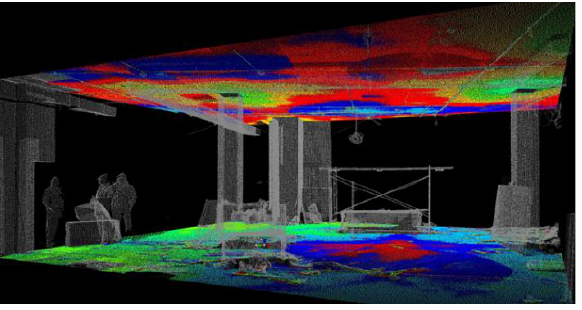
Figure 8 . 3D point cloud for measurements.